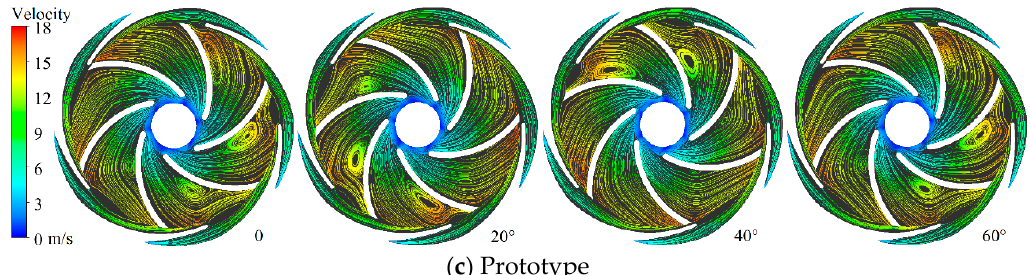
Figure 9. Evolution processes of the transient flow field inside the impeller and guide vane with different blade numbers of the guide vane.